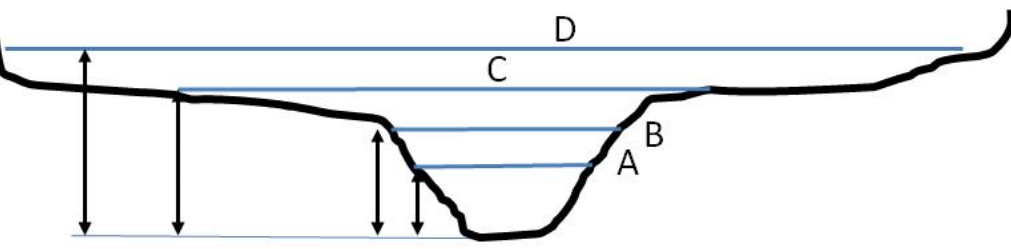
Figure 3. Schematic representation of a river cross-section showing a main channel. Line A corresponds to low water level; line B indicates a near bankfull condition at the main channel; lines C and D represent water levels during flood events. Vertical arrows denote water depth at the main channel (from [3]).